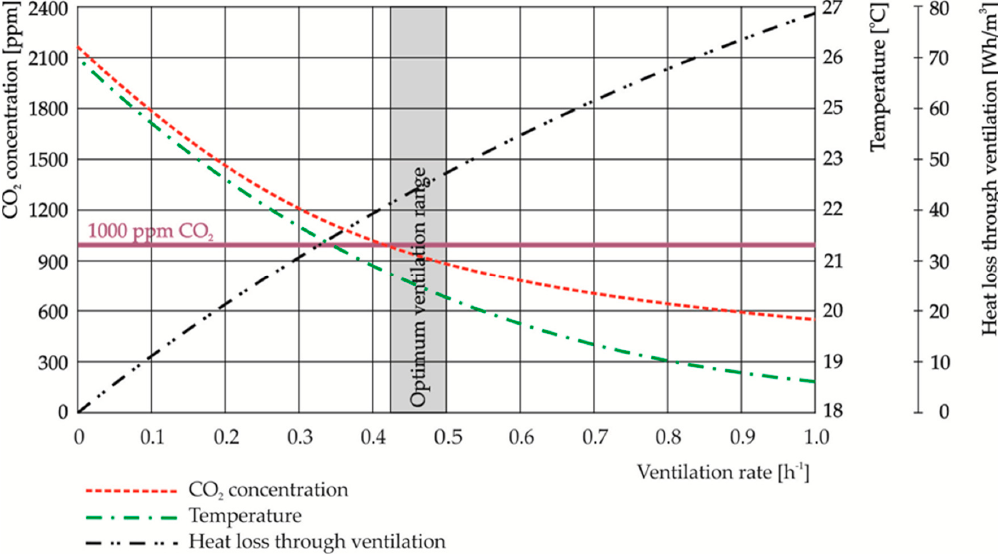
Figure 3. Example graph of performance parameters optimisation for a ventilation system in an apartment .